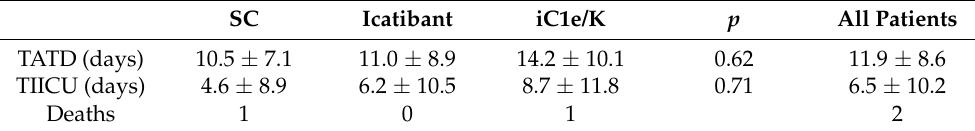
Table 3. Primary outcomes of patients included in the study.